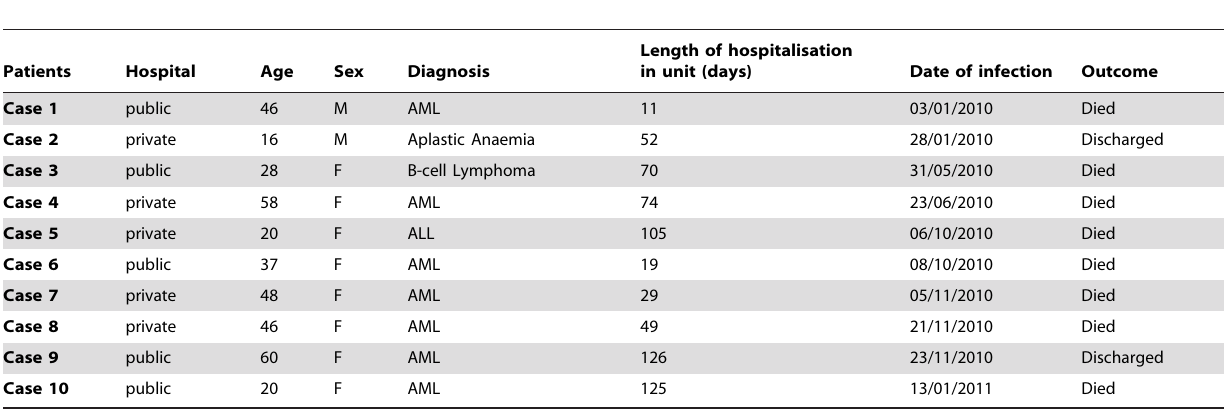
Table 1. Characteristics of patients with Pseudomonas aeruginosa bloodstream infection in a haematology intensive care unit of a tertiary academic hospital in Cape Town, South Africa, January 2010–January 2011.